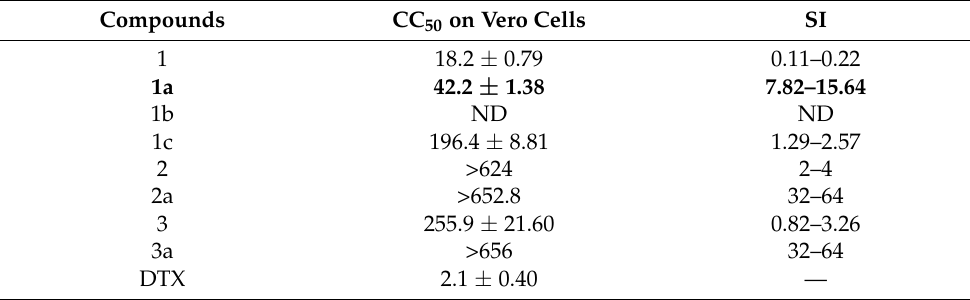
Table 2. Cytotoxic activity and SI of natural and semi-synthetic